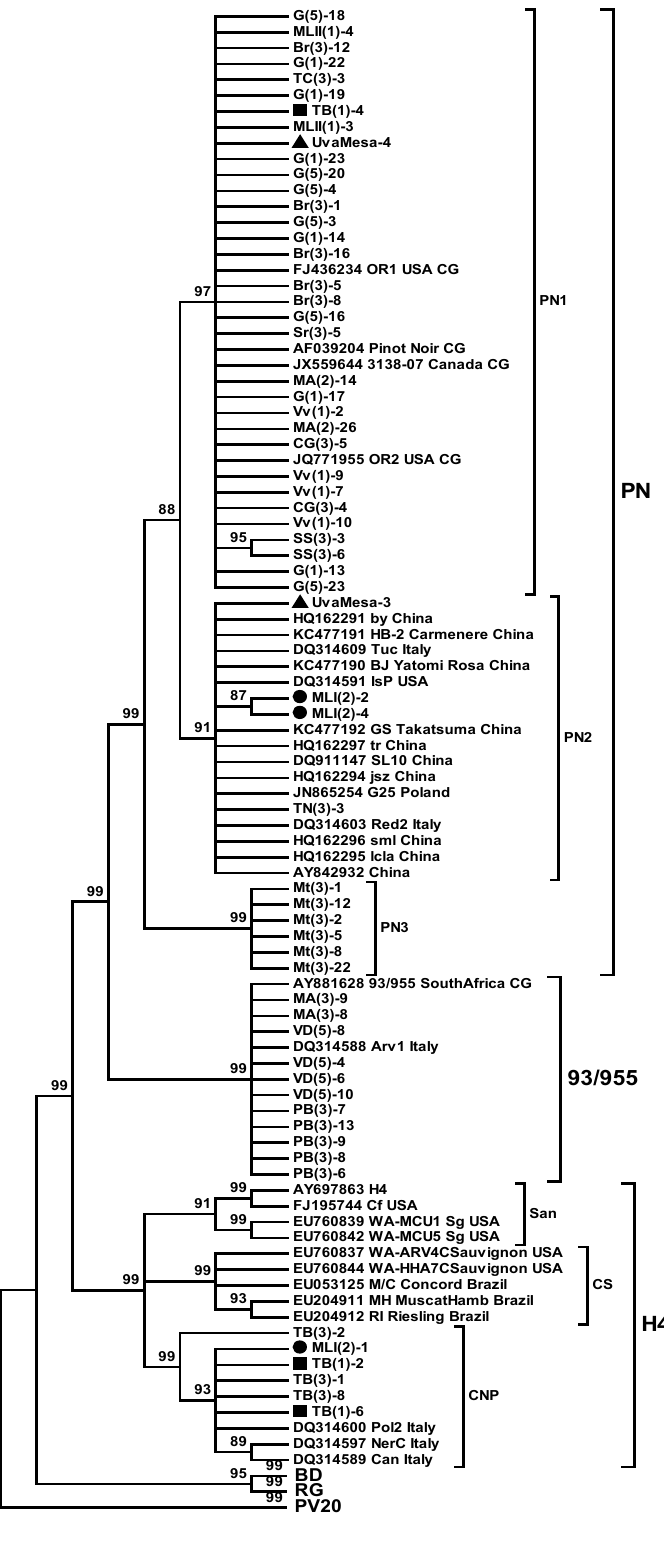
Figure 1. Evolutionary relationships among glob- al sequence variants of the capsid protein gene of Grapevine leafroll-associated virus 2 (GLRaV-2). The evolutionary history was inferred using the Minimum Evolution method, and the optimal tree with the sum of branch length = 1.30850251 is shown. The percentages of replicate trees in which the associated taxa clustered together in the bootstrap test (1000 replicates) are shown. The evolutionary distances were computed using the Kimura 2-parameter method and are in the units of the number of base substitutions per site. The analysis involved 107 nucleotide sequences. Capsid gene sequences retrieved from complete genome sequences are indicated with the suffix CG. Groups BD, RG and PV20 were collapsed for clarity. Matching black symbols indicate divergent sequence variants obtained from the same